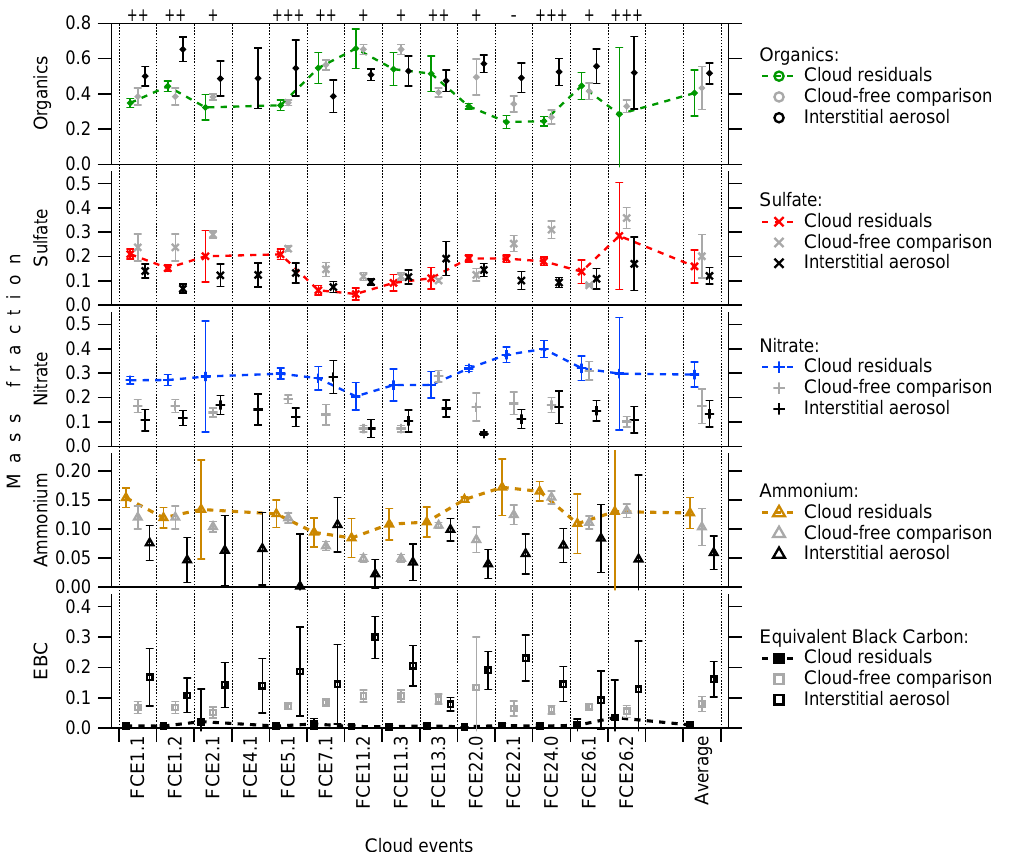
Figure 4. Mass fractions of organics, sulfate, nitrate, ammonium, and EBC in the submicron aerosol, for cloud residuals, interstitial aerosol, and the cloud-free comparison periods. Error bars indicate standard deviations during the averaging period, thereby illustrating the variability during the cloud events. The similarity between the trajectories for cloud events and cloud-free periods from Fig. 1 and Table 1 is indicated above the top